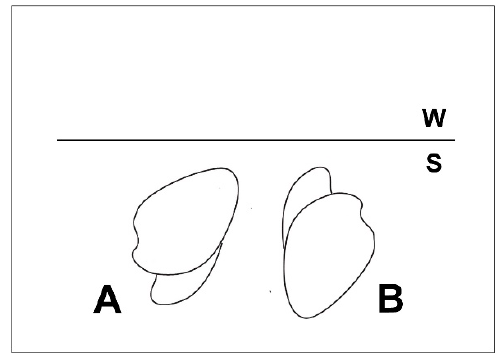
Figure 4. Generalized clam orientation during upward escape burrowing. ( A ) Shell anterior downward; foot pushes animal upward; ( B ) Shell anterior upward; foot pulls animal upward. S—sediment; W—water.